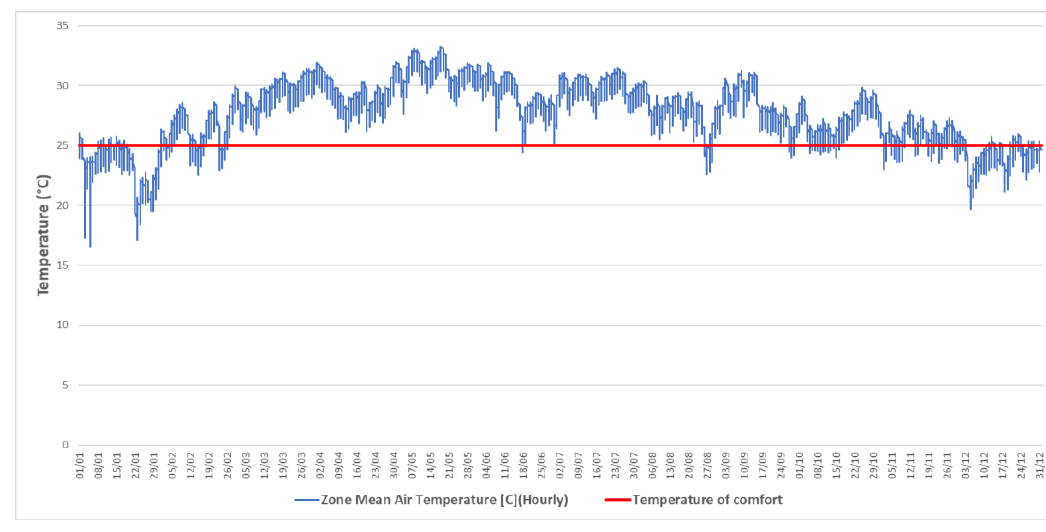
Figure 15. Annual indoor temperatures considering an urban transmittance of 0.40.